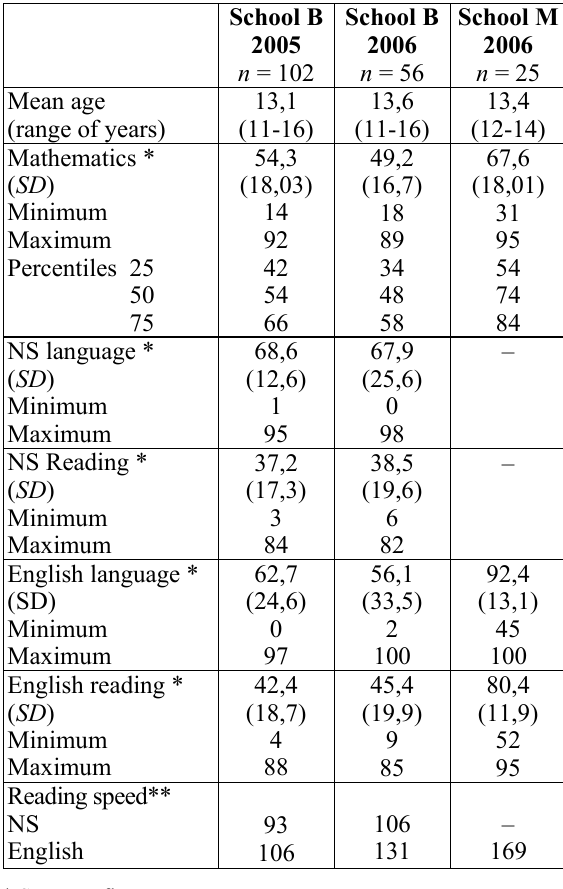
Table2: Grade 7 mean performance in language proficiency, reading ability and mathematics